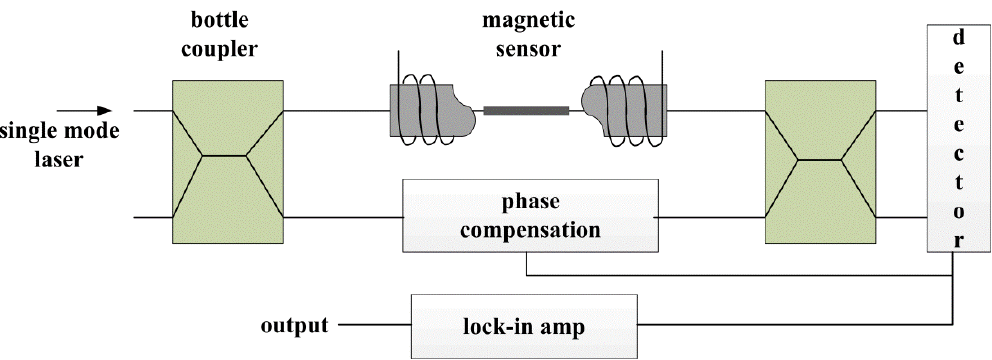
Figure 11. Experimental scheme of fiber optic magnetic